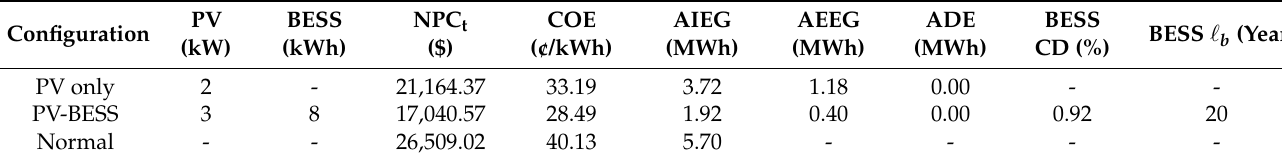
Table 9. Optimal results for both system configurations with Option 4